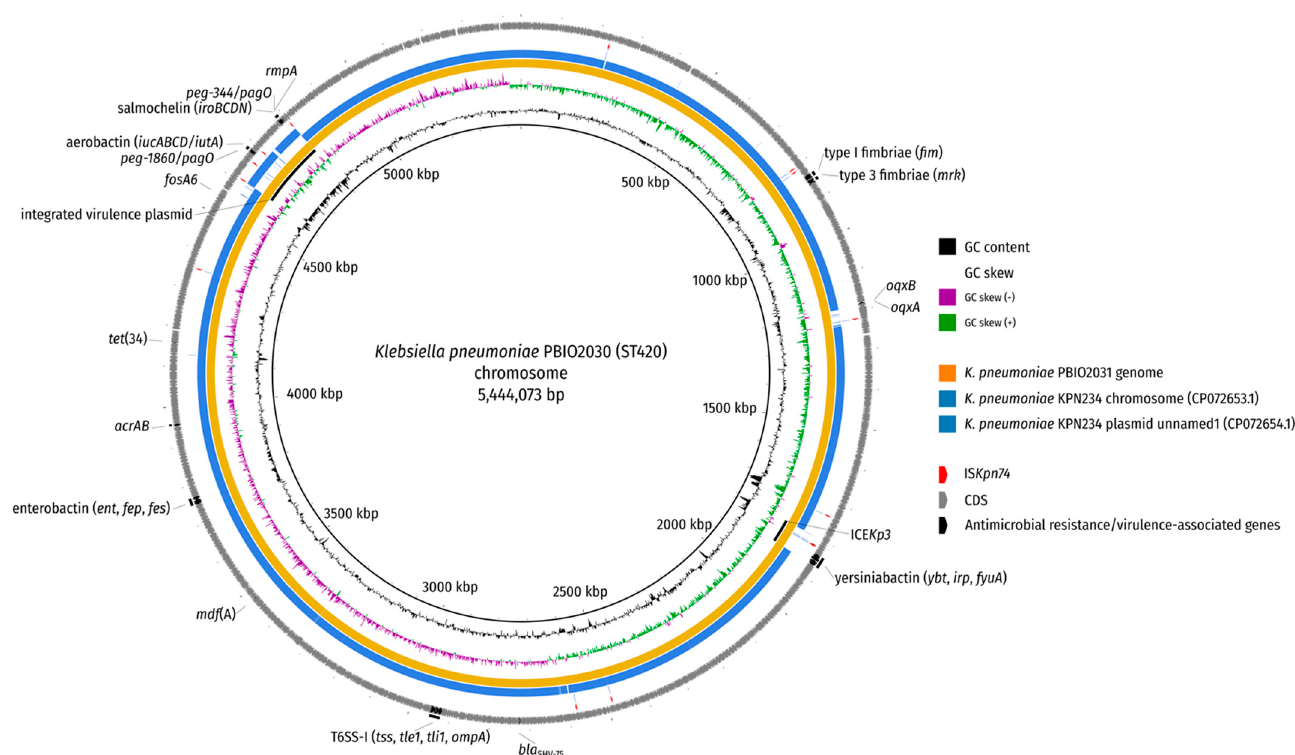
Figure 2. BLAST comparison of K. pneumoniae PBIO2030 chromosome. The genome of isolate PBIO2031 (blood culture) and two replicons of a publicly available ST420 isolate (KPN234; NCBI accessions: CP072653.1 (chromosome) and CP072654.1 (plasmid unnamed1) were aligned against the chromosome of PBIO2030 (wound) by BLAST (-task megablast -evalue 1e-10 -dust no). Antimicrobial resistance genes as well as virulence-associated genes are depicted in addition to regions of interest (inserted virulence plasmid, ICE Kp3 ) and the insertion sequence IS Kpn74 .